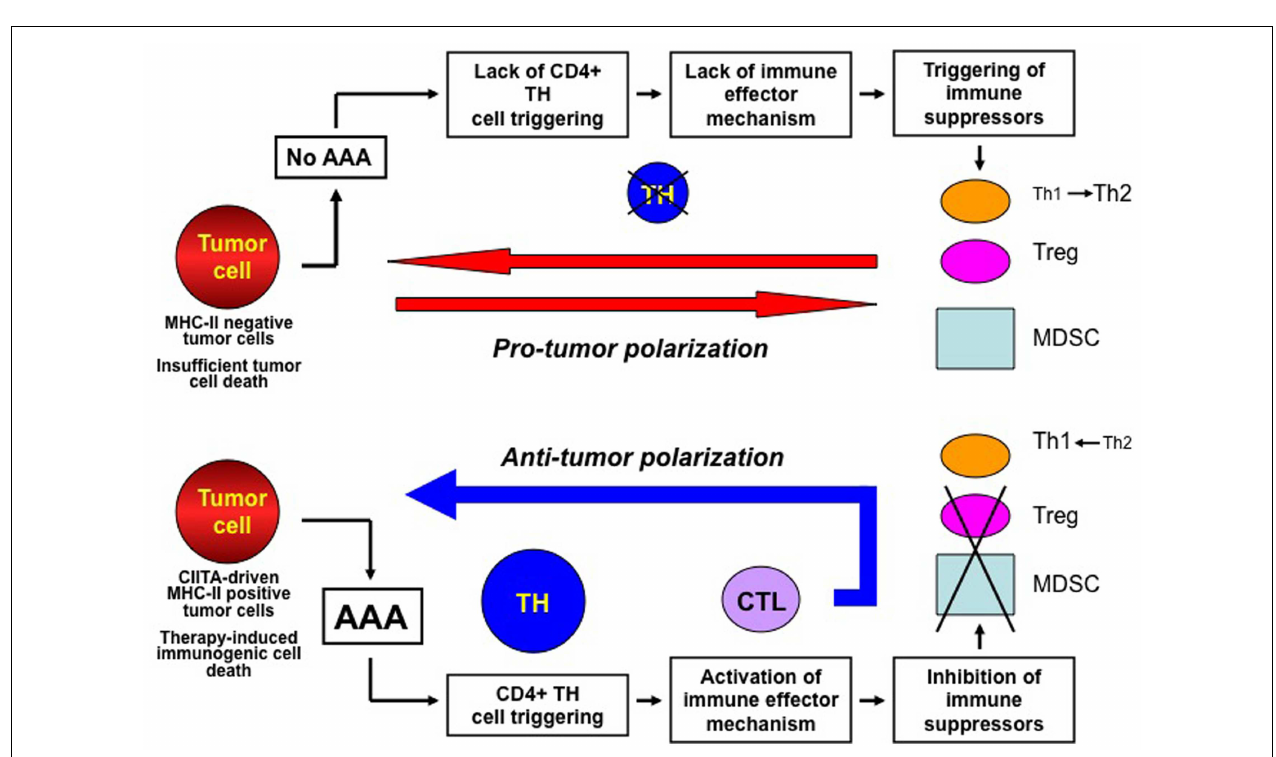
activation and increase number of regulatoryT cells (Treg) and myeloid-derived-suppressor cells (MDSC), which cumulatively create a pro-tumor polarization of the tumor microenvironment. Presence of AAA (lower part of the Figure) generated, for example, by MHC class II expression in tumor cells or by therapy-induced immunogenic cell death efficiently triggers tumor specificTH cells and this is instrumental to both activate immune effector mechanisms such as CTL and repress and/or prevent suppressor mechanisms on protective immunity.This results in the generation of an anti-tumor microenvironment and in a strong adaptive immune response against the